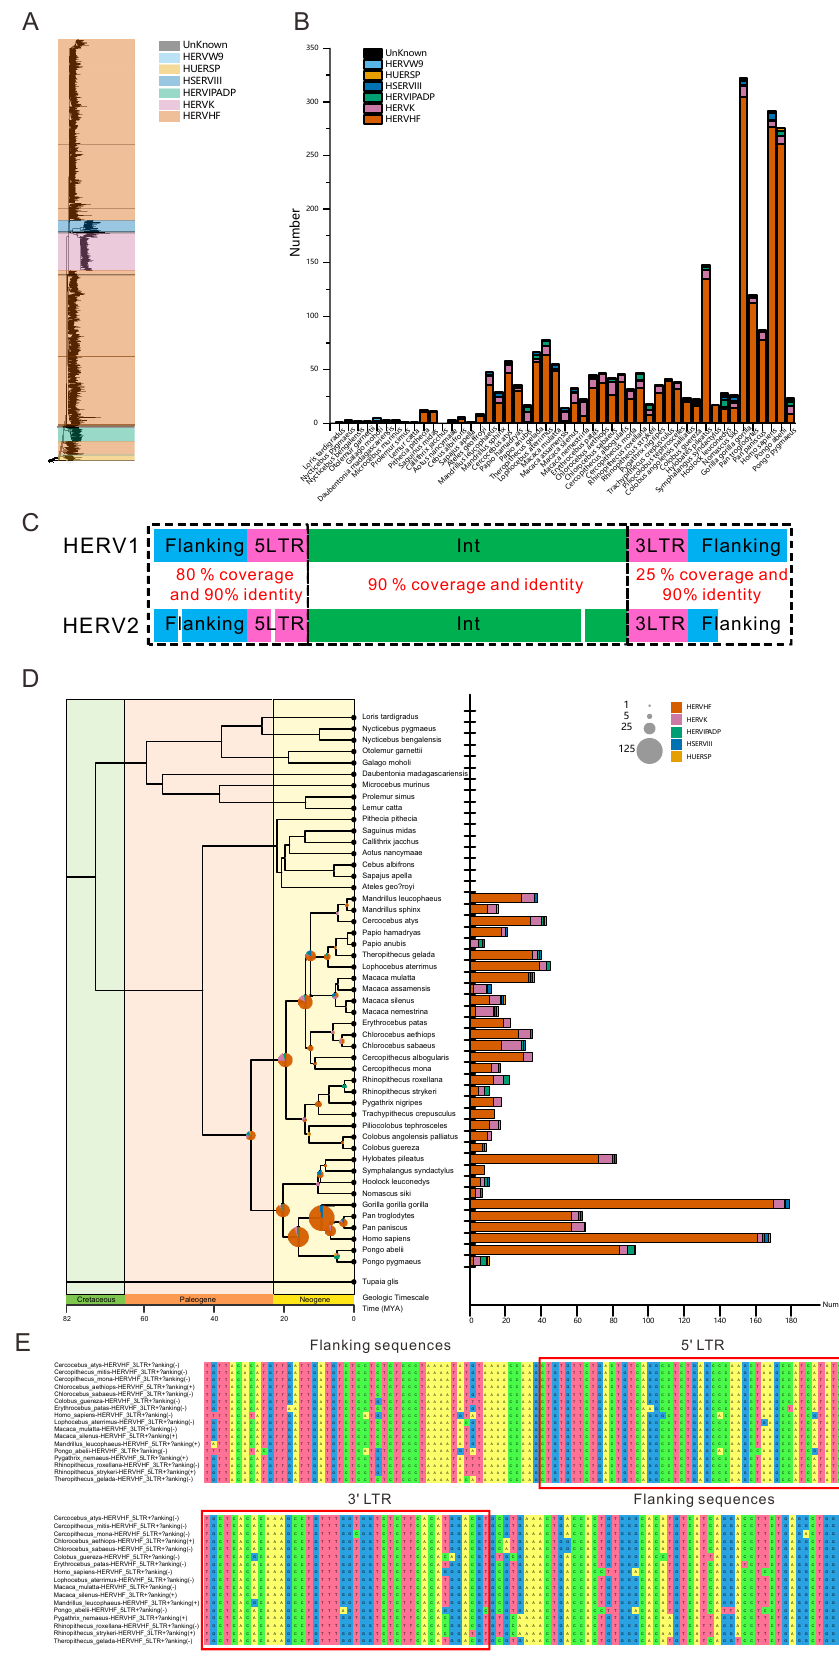
Figure 1. The distribution, classification, and vertical transmission of F-HERVs in 49 primates. ( A )